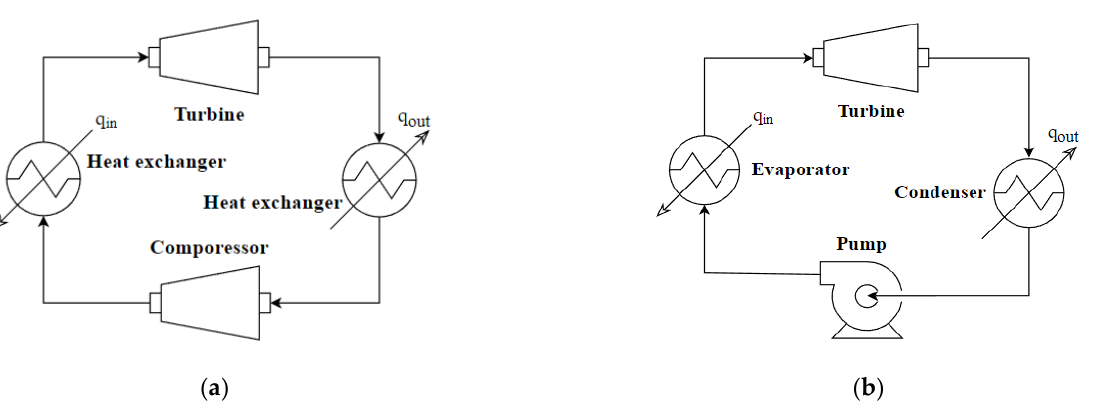
Figure 1. Schematic of CO 2 power cycles. ( a ) Brayton cycle. ( b ) Rankine cycle.